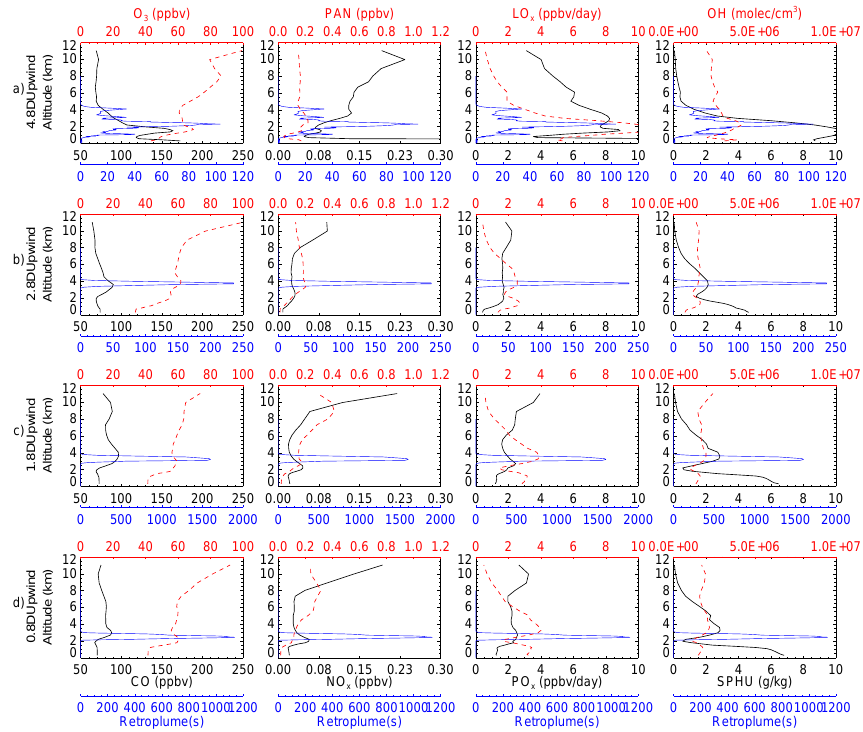
Fig. 7. GEOS-Chem profiles of tracer gases (CO, O 3 , PAN, etc.), ozone production/loss rates ( P O x , L O x ), OH concentration, and specific humidity (SPHU) at four upwind times along the transport pathway for event 2. The four times were selected to show different stages during the transport. Upwind times are indicated to the left of each row. Plume location and altitude are determined by folded retroplume analysis at the indicated upwind time (Fig. 3). Simultaneous retroplumes (in blue) are shown in units of residence time (second), which can be viewed as vertical dispersions of plume air masses over altitude in the column containing the highest folded retroplume concentration such that the retroplume profiles in each row are identical. Each plot shows two GEOS-Chem profiles, the colors of which correspond to the colors of the upper and lower x